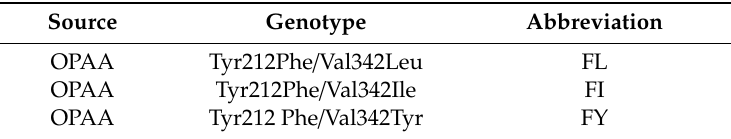
Table 4. Enzyme genotypes